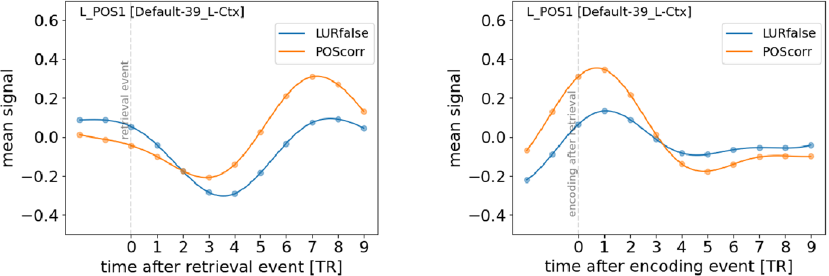
Figure 3. Mean signals for a region exhibiting a significant difference in the neural responses quite late after the retrieval event. On the left, the signals are temporally tied to the retrieval event. On the right, the signals are temporally tied to the encoding event following the retrieval